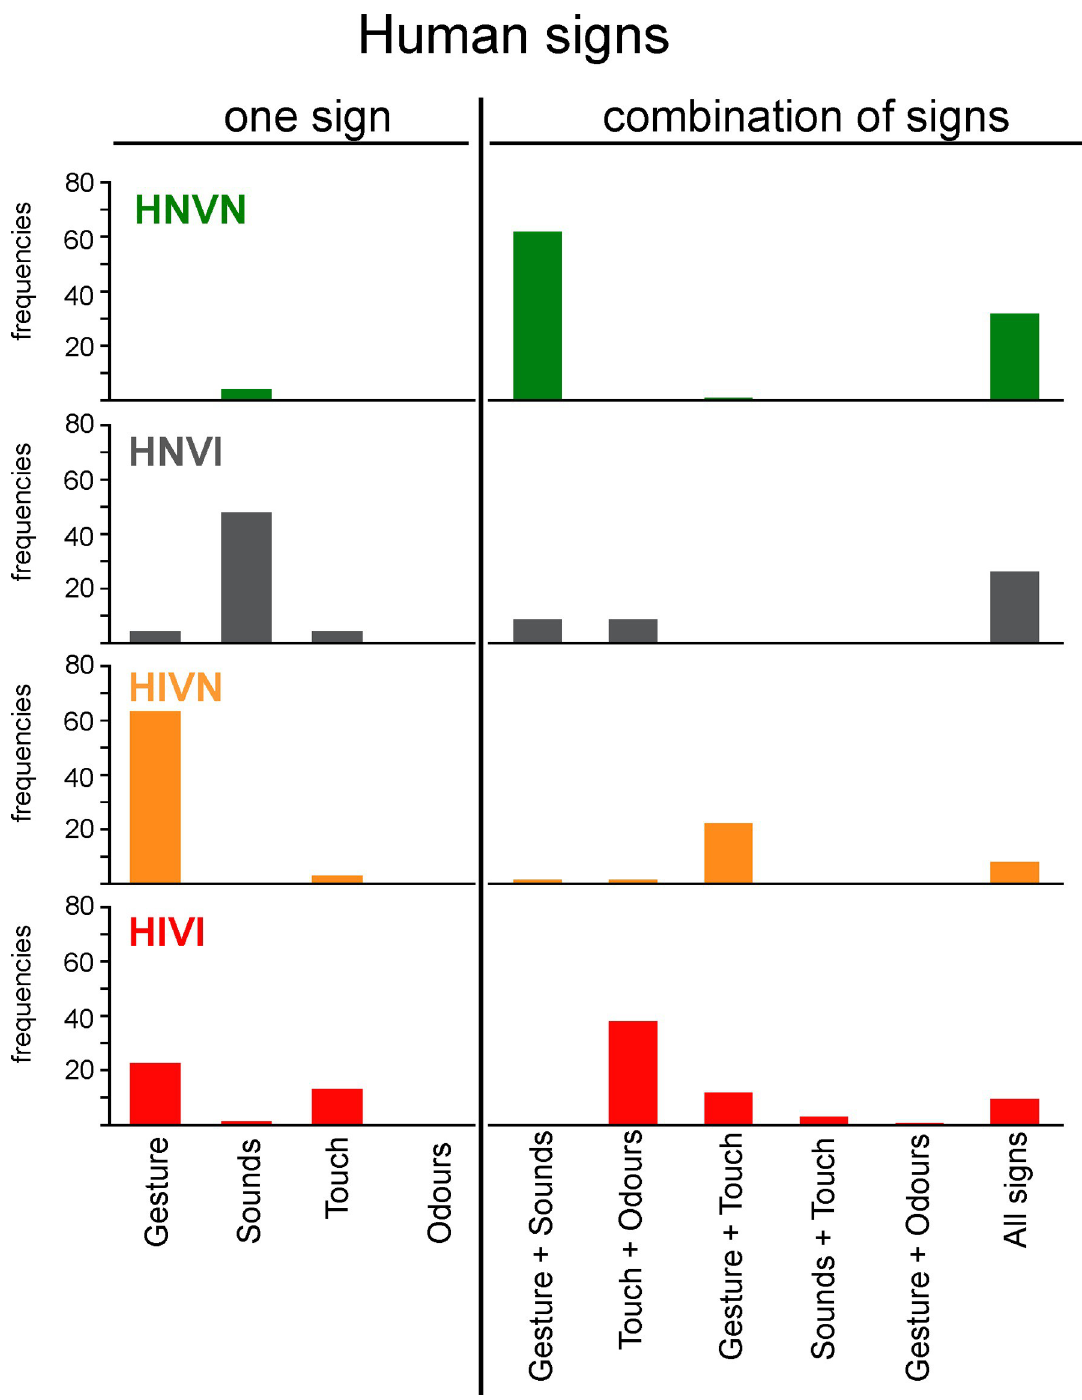
Fig 9. For each group (panels), frequencies at which different unique signs (left) and combinations of signs (right) were used by owners to communicate with their dogs. HNVN = hearing normal vision normal (green), HNVI = hearing normal vision impaired (grey), HIVN = hearing impaired vision normal (orange), HIVI = hearing impaired vision impaired (red). gesture and touch combination (12%), and the combination of all four signs (9%). In sum- mary, “preferred” signs clearly emerged for dogs with either no or one sensory impairment,